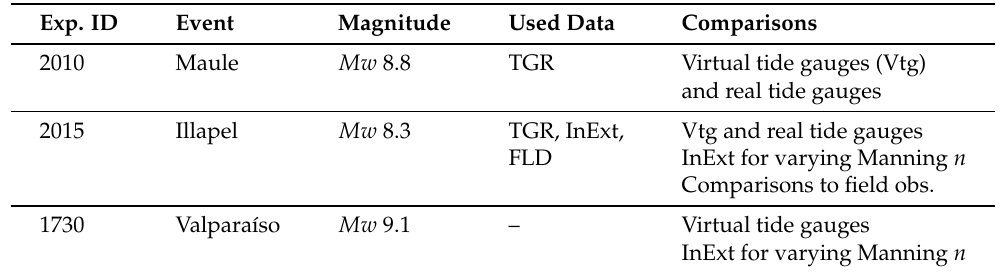
Table 2. Simulation overview for the three experiments. Abbreviations for the available data used in the study are tide gauge records (TGR), inundation extent (InExt), and flow depth (FLD). Exp. ID Event Magnitude Used Data Comparisons 2010 Maule Mw 8.8 TGR Virtual tide gauges (Vtg) and real tide gauges 2015 Illapel Mw 8.3 TGR, InExt, Vtg and real tide gauges FLD InExt for varying Manning n Comparisons to field obs. 1730 – Virtual tide gauges InExt for varying Manning